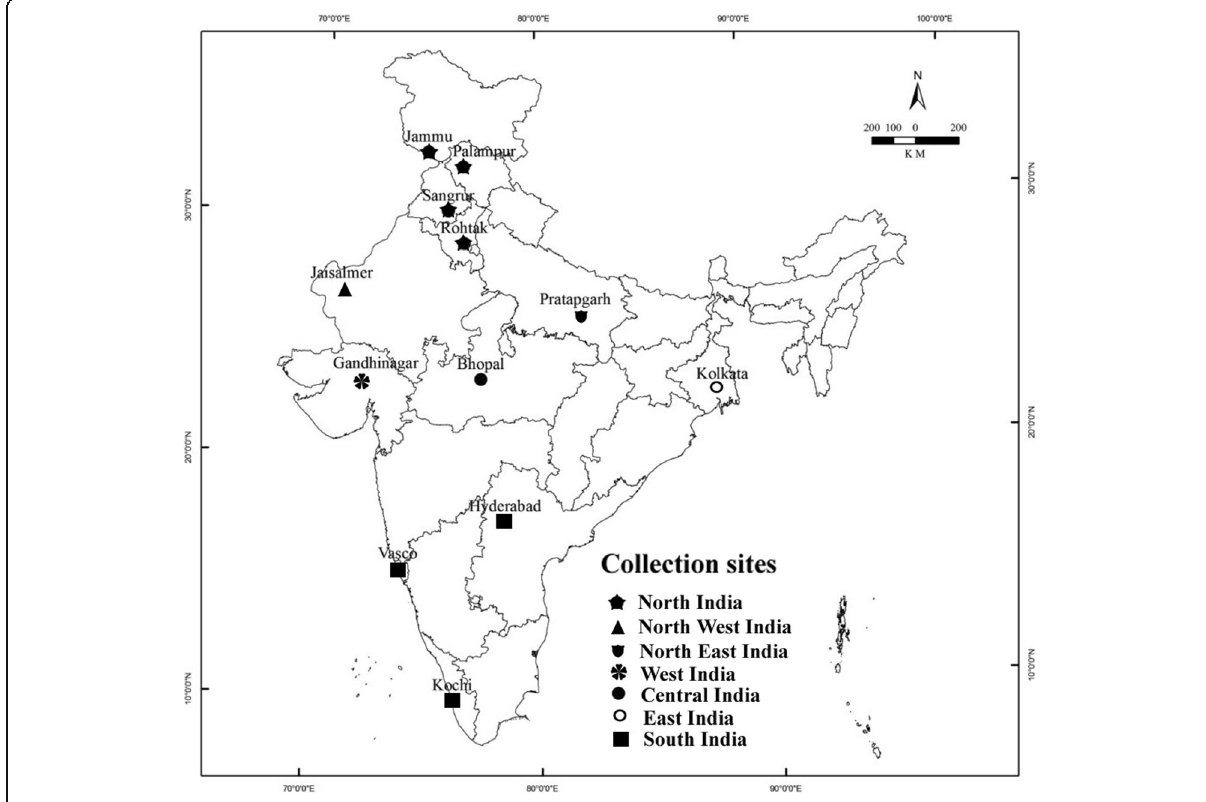
Fig. 1 Map showing Aloe vera sample collection sites from different places of